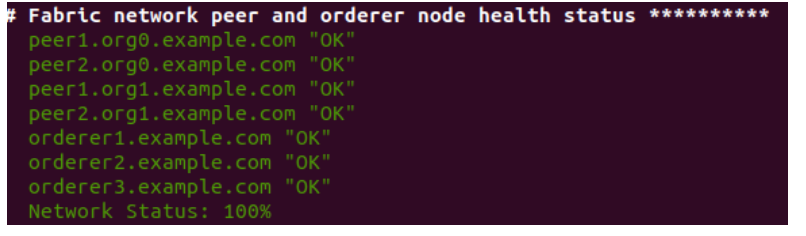
Figure 7. Smart contract network information.